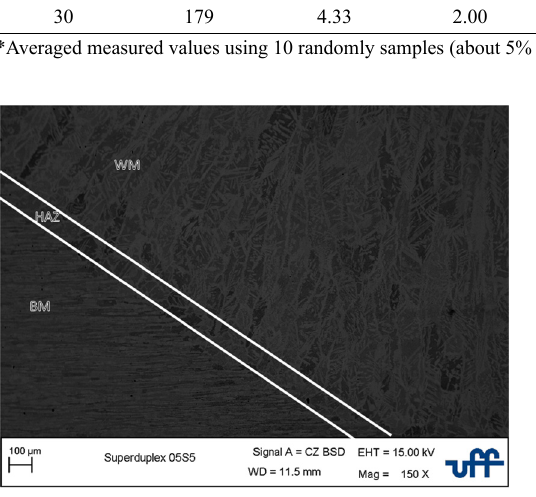
Figure 16. SEM image of the welding zones on the SDSS for heat input of 2.2 kJ mm